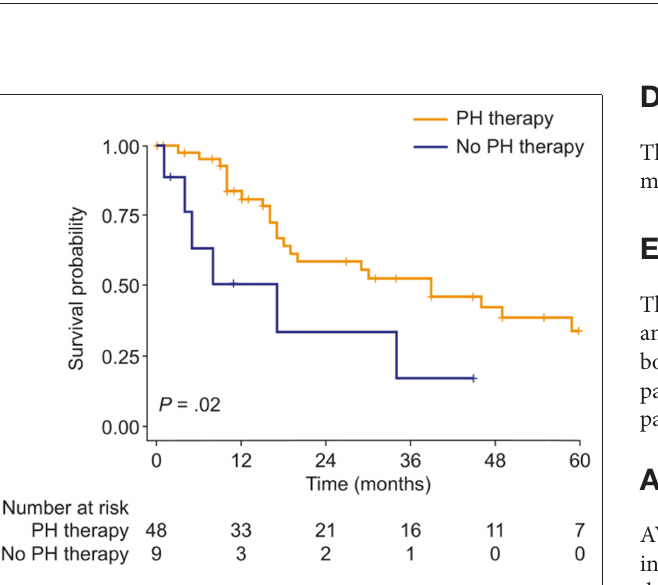
FIGURE 2 | Kaplan–Meier curves of survival probability in patients with either (A) , mild-to-moderate or (B) , severe PH due to COPD, stratified by use of targeted PH therapy. PH, pulmonary hypertension.